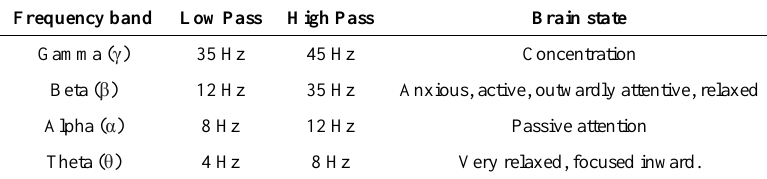
Table 1. The range of Low Pass and High Pass values for each frequency band